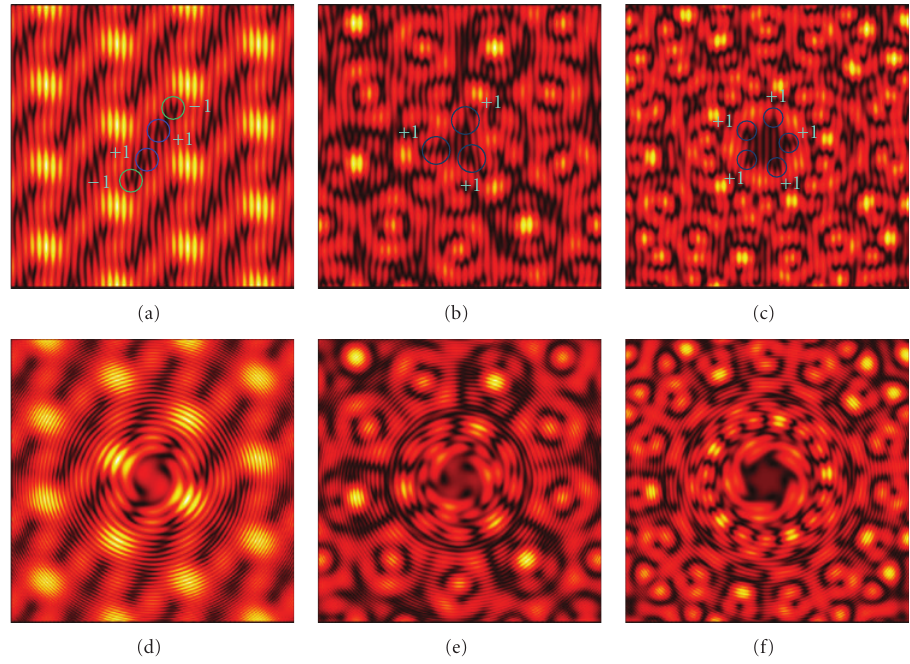
Figure 8: Analysis of presence of singularity in complex 3D vortex lattices. Taking the multiples of relatively phase-shifted three beams, the numbers of interfering beams involved are, respectively, 6 beams (first column), 9 beams (second column), and 15 beams (third column). (a)–(c) The fork formation, while the pattern is interfered with a plane wave launched at a large angle from the axis. (d)–(e) The spiral formation while the pattern is interfered with a spherical wave. The points of singularities are clearly visible as the signature of the presence of vortex distribution in the designed